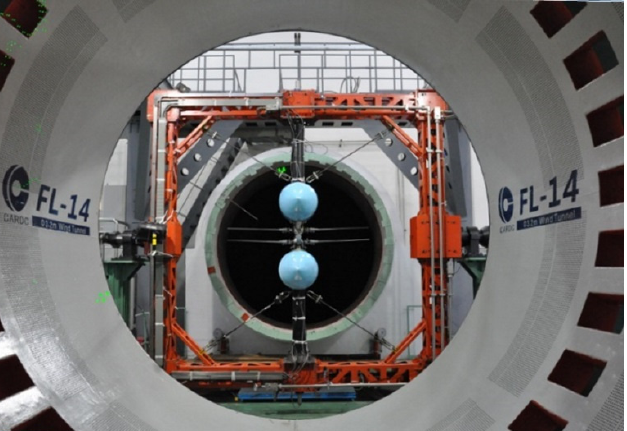
Figure 3. Counter-rotating coaxial rotor system installed on the test rig in the wind tunnel test sec- tion.